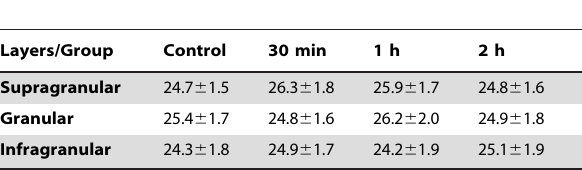
Table 1. Acute sensory stimulation does not affect the numerical densities of ARO-positive cells across cortical layers of V1.